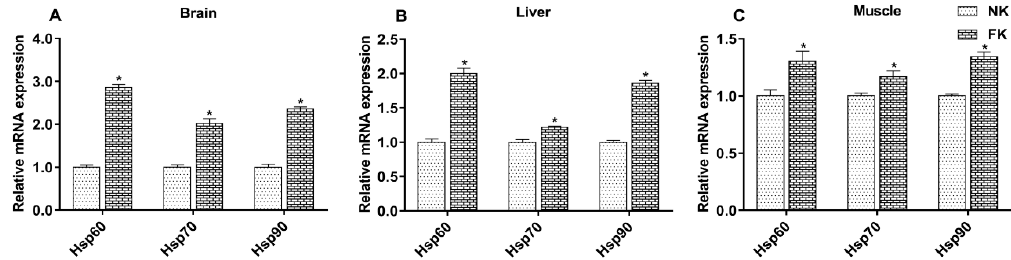
Figure 2. Expression levels of Hsp60 , Hsp70 , and Hsp90 mRNA in the brains ( A ), livers ( B ), and muscles ( C ) of laying hens with normal keel (NK) or fractured keel (FK). * p ≤ 0.05.